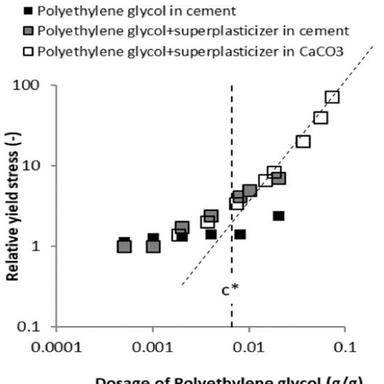
Relative yield stress of cement pastes and calcite as a function of Polyethylene glycol dosage (g/g powder). The superplasticizer is a PCE. Its dosage is 1 g/l in cement and 5 g/l in CaCO3 paste, W/Cement = 0.4 and W/ CaCO3 = 0.55. The relative yield stress is the ratio between the yield stress of the paste with Polyethylene glycol and the yield stress of the reference paste without Polyethylene glycol. The vertical dashed line corresponds to the critical polymer concentration c defined in the text. Reprod